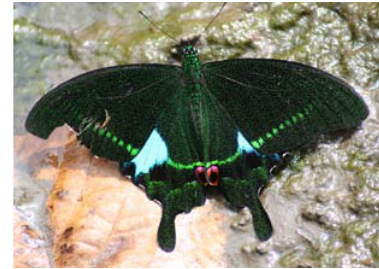
Image 23. Papilio alcmenor